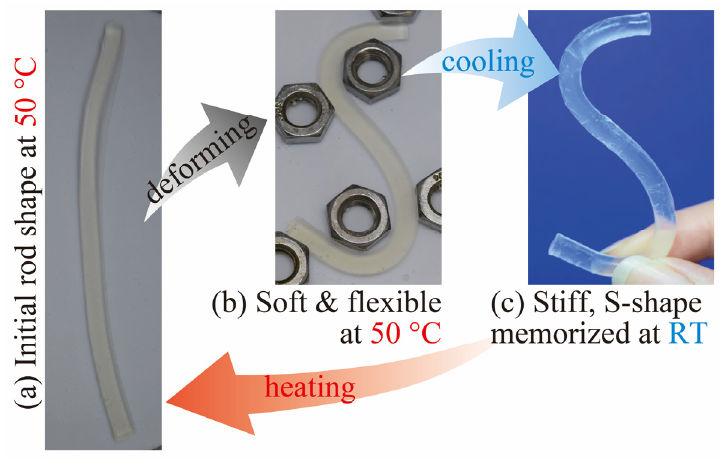
Figure 5. Photographs of the shape-memory function of poly(SA- co -MPGA) hydrogel with x SA = 0.5: ( a , b ) in water at 50 °C and ( c ) at room temperature (~20 °C).